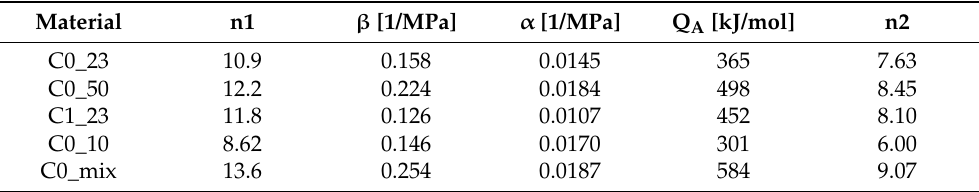
Table 4. Material constants and activation energy of the hot compressed composites, evaluated from the constitutive relations in Equation (2).